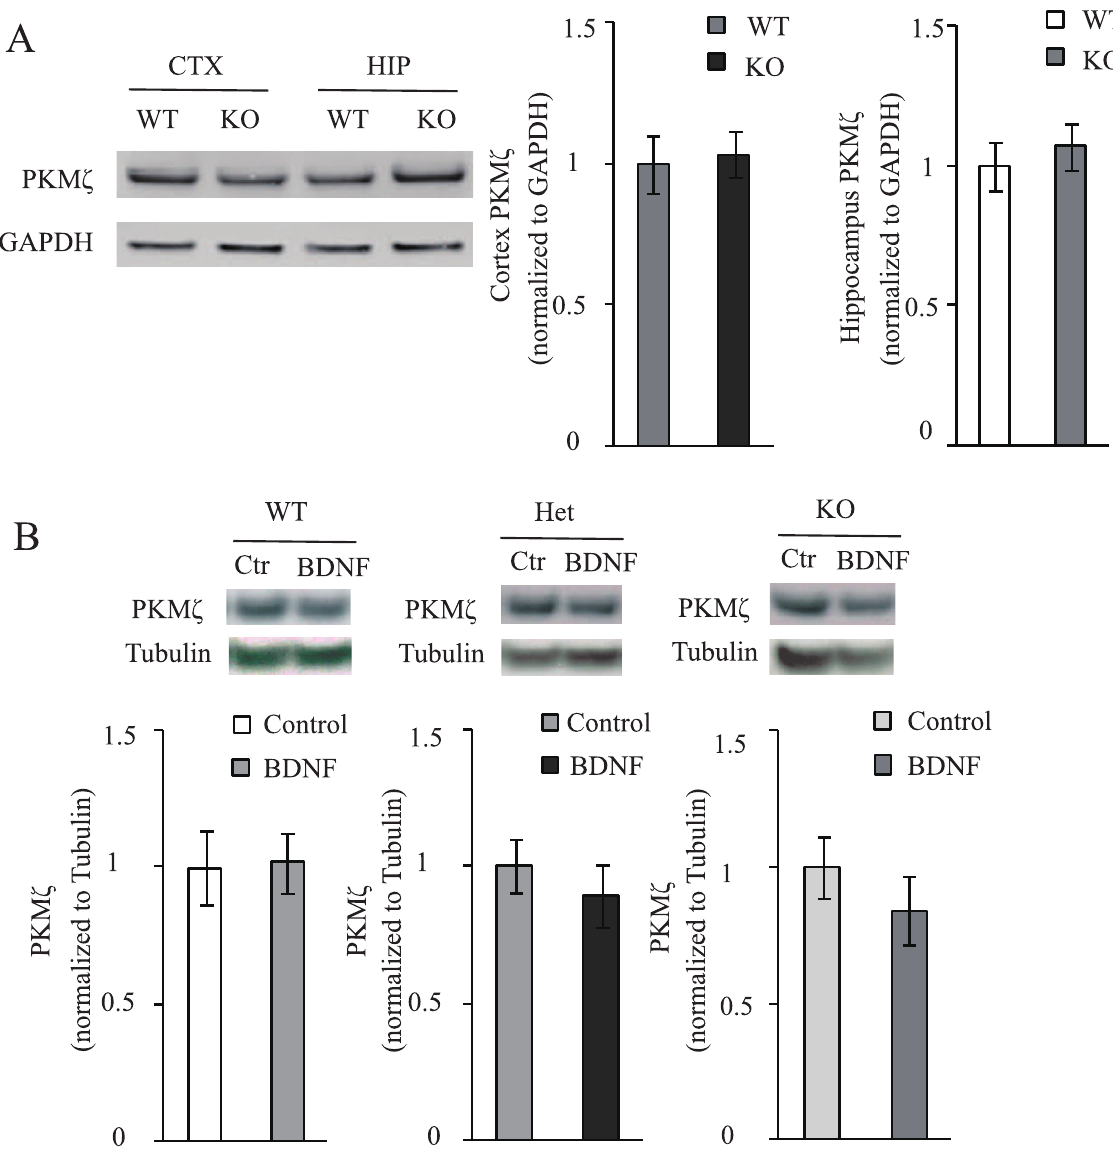
Figure 2. Steady-State PKM f protein level is not regulated by BDNF. (A) PKM f protein level in cortex and hippocampus of BDNF KO and WT littermates. At postnatal day 18, cortex or hippocampus from BDNF KO and WT littermates were dissected and subjected to Western blot. Representative blots and quantification of data were shown. GAPDH was used as loading control. (n=5–8 independent experiments). (B) PKM f expression in primary neuron cultures derived from different genotypes after BDNF treatment. DIV 7 cortical primary cultures of WT, Het or KO genotype were separately treated with BDNF (100 ng/ml) or vehicle for 24 hours. For each experiment, BDNF treatment group was normalized against vehicle treatment group. Representative blots are shown on top of the quantification of data. (n=5 independent experiments).